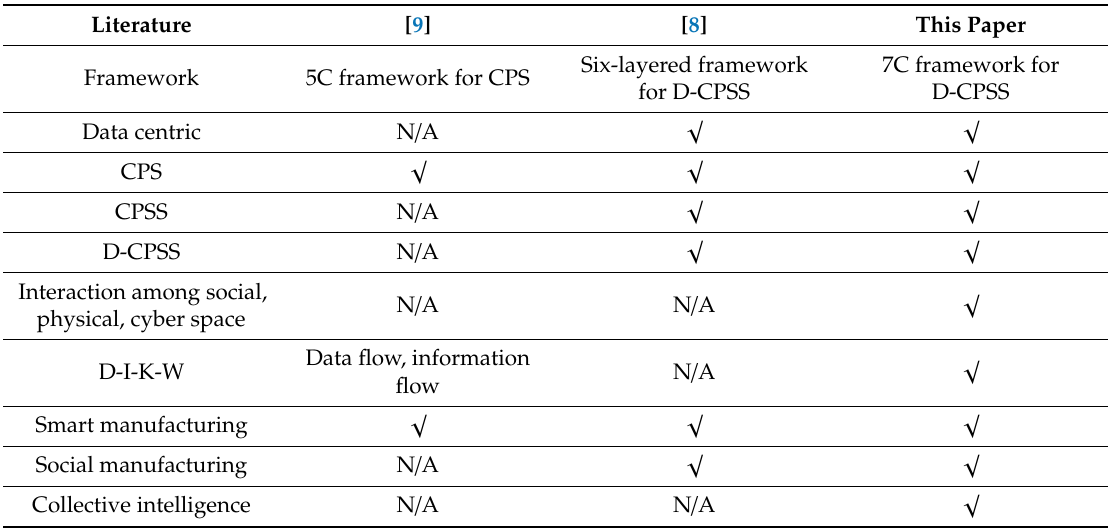
Table 5. The comparison of the proposed framework with other